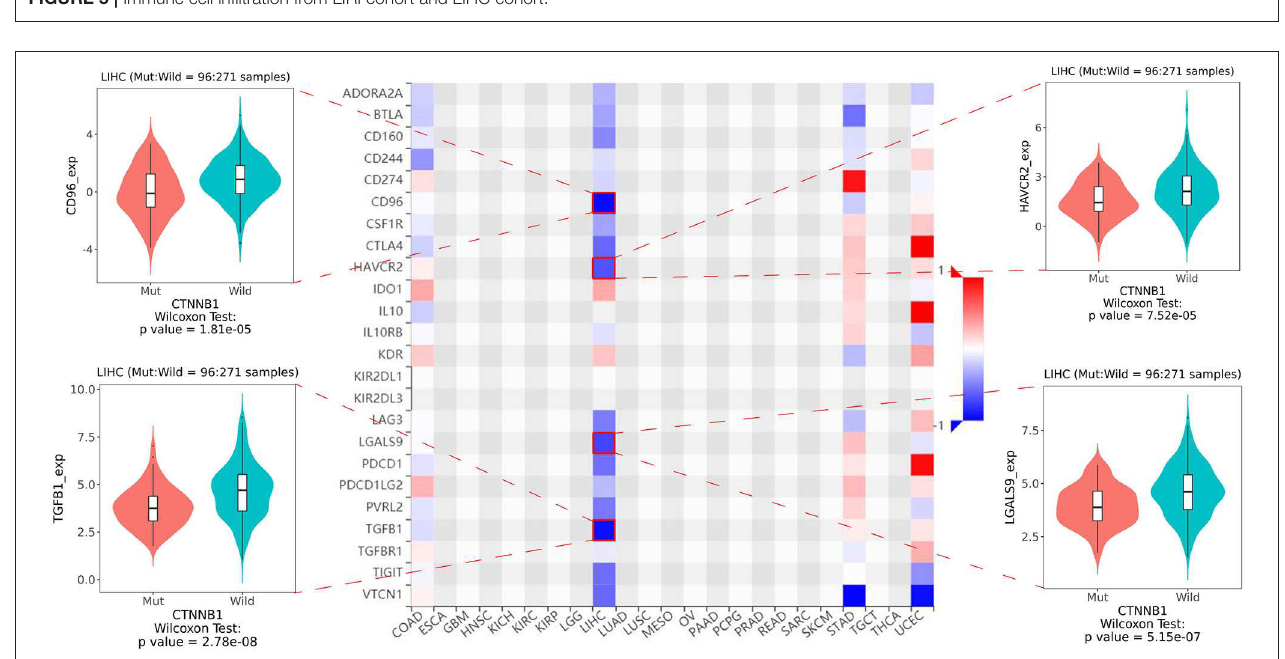
FIGURE 6 | The heatmap of 24 types of immune inhibitors and significant results from correlation analysis.